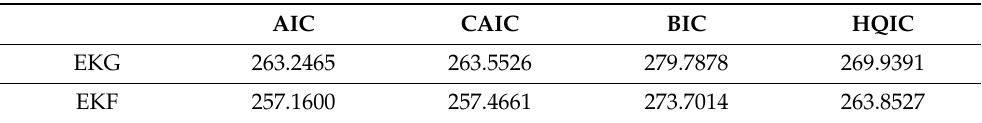
Table 12. AIC, BIC, CAIC, and HQIC for different sets and different model for Australian athletes data set.